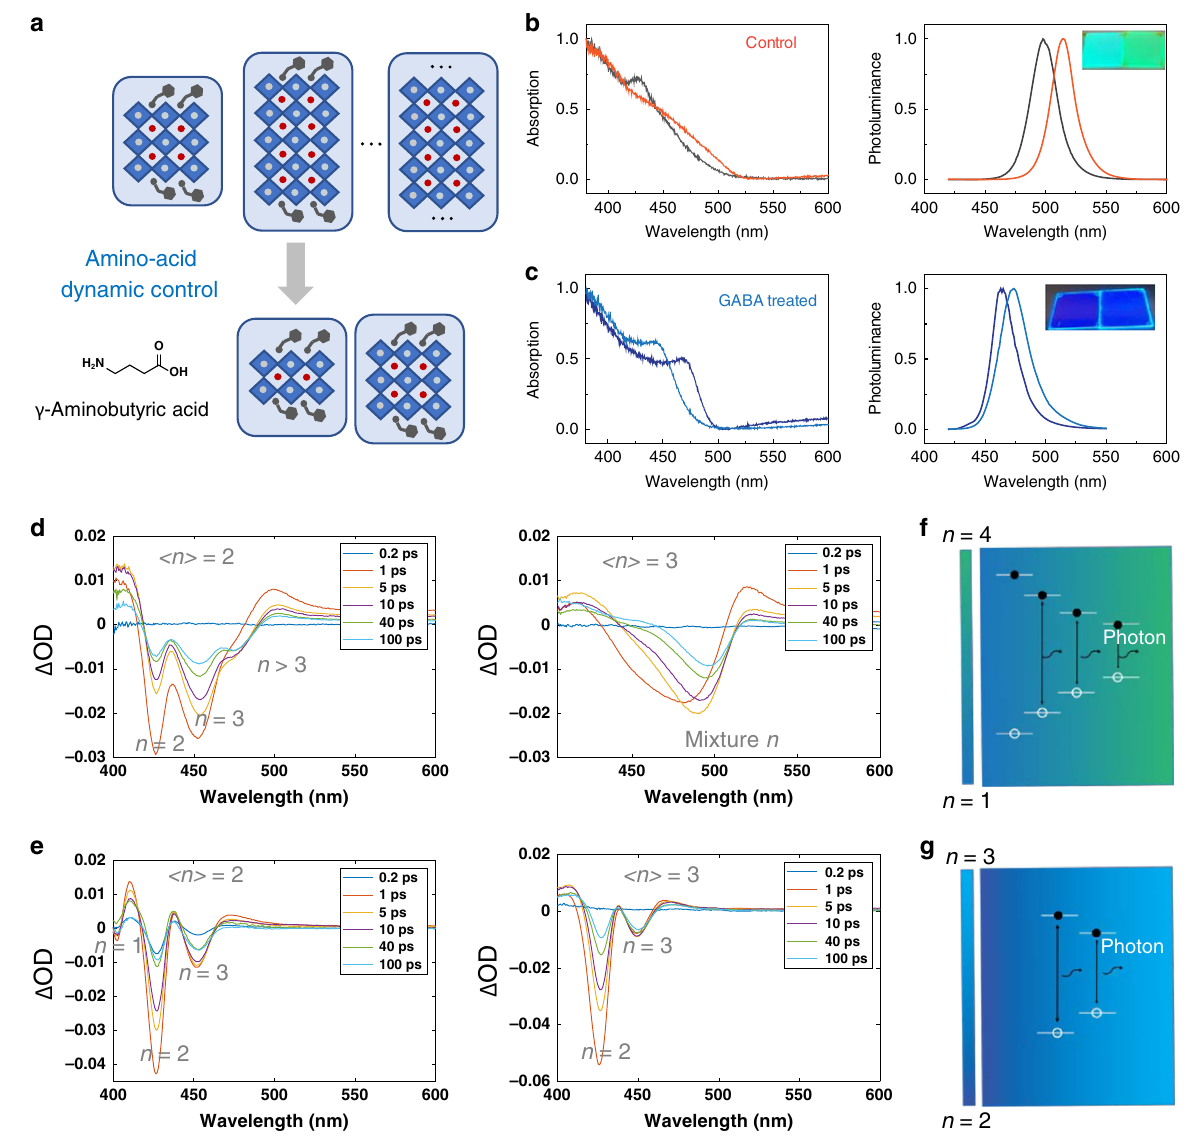
Fig. 1 Photoexcited carrier dynamics of GABA-treated CsPbBr 3 QWs. a Schematics depicting suppression by GABA of n < 2 and n > 3 QWs. b , c Absorption and photoluminescence spectra of the control ( b ) and GABA-treated ( c ) CsPbBr 3 thin fi lms. Inset: photograph of the perovskite fi lms under external photoexcitation. d , e TAS of control ( d ) and GABA-treated ( e ) CsPbBr 3 QWs with < n > = 2 and 3 at different delay times. f , g Schematics of photocarrier dynamics and recombination of the control ( f ) and GABA-treated ( g ) CsPbBr 3 thin fi lms.